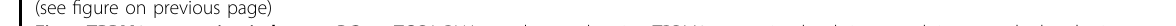
Fig. 1 TRPM8 expression in human PCa. a TCGA RNA-seq dataset showing TRPM8 expression levels in normal tissues and related primary tumors. b TCGA, SU2C, and Beltran RNA-seq datasets analysis stating TRPM8 expression levels in benign prostate tissue, primary PCa and castration resistant metastatic adeno-PCa. Data were analyzed using a two-tailed Wilcoxon – Mann – Whitney test with a signi fi cance level set at 5%. c TRPM8 mRNA levels in 52 matched normal and adjacent PCa samples showing increased expression of TRPM8 in PCa compared to adjacent normal tissue in 36 cases, reduction in 5 and comparable levels in 11. d Relative amount of PM-associated 6TM (full length) and ER-associated 4TM TRPM8 transcript isoforms in 52 matched normal (N) and primary PCa (PCa) samples, as retrieved in TCGA RNA-seq dataset. e TRPM8 immunostaining score of a commercially available PCa tissue microarray (TMA). TRPM8 immunostaining was scored as weak (0), moderate (1), high (2), or very high (3) on 5 normal prostate cores and 171 PCa cores representing 57 different cases (3 cores × tumor). Representative images of scored normal prostate tissue and prostate adenocarcinoma cores are shown. Results are presented as percentage of tumors scored 0-to-3 respect to tumor stage. Stage I: score 1 = 36%; score 2 = 36%; score 3 = 28%; stage II: score 1 = 9%, score 2 = 64%, score 3 = 27%; stage III: score 1 = 8%; score 2 = 38%; score 3 54%; stage IV: score 1